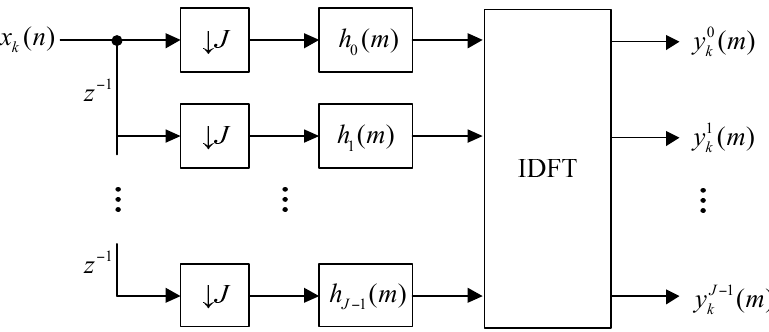
Figure 3. The optimized digital channelization receiver Figure 2. The optimized digital channelization receiver architecture.